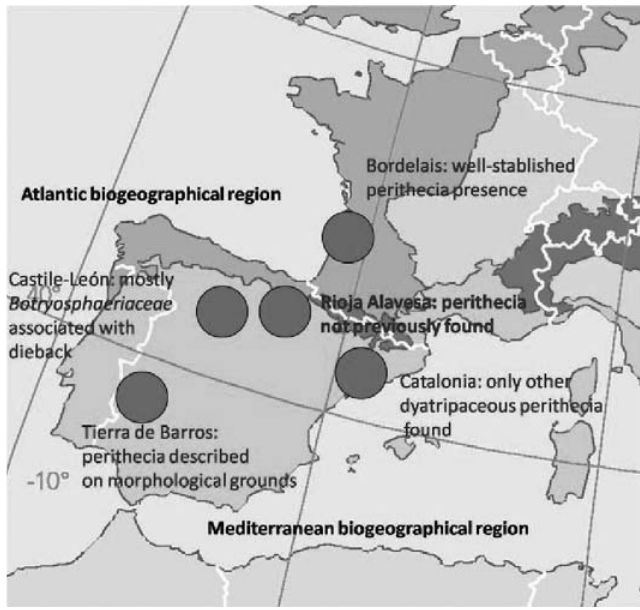
Fig. 1. Biogeographical regions of south western Europe (Anonymous, 2007) with the location of the wine regions mentioned in the text